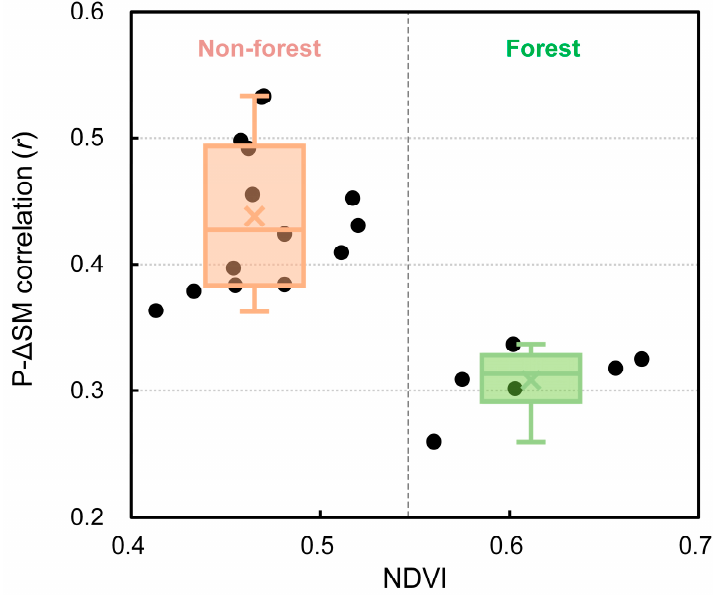
Figure 8. Correlations between daily precipitation amount (P) and observed soil moisture change ( Δ SM). The results are plotted as a function of NDVI and grouped by land cover for each station.